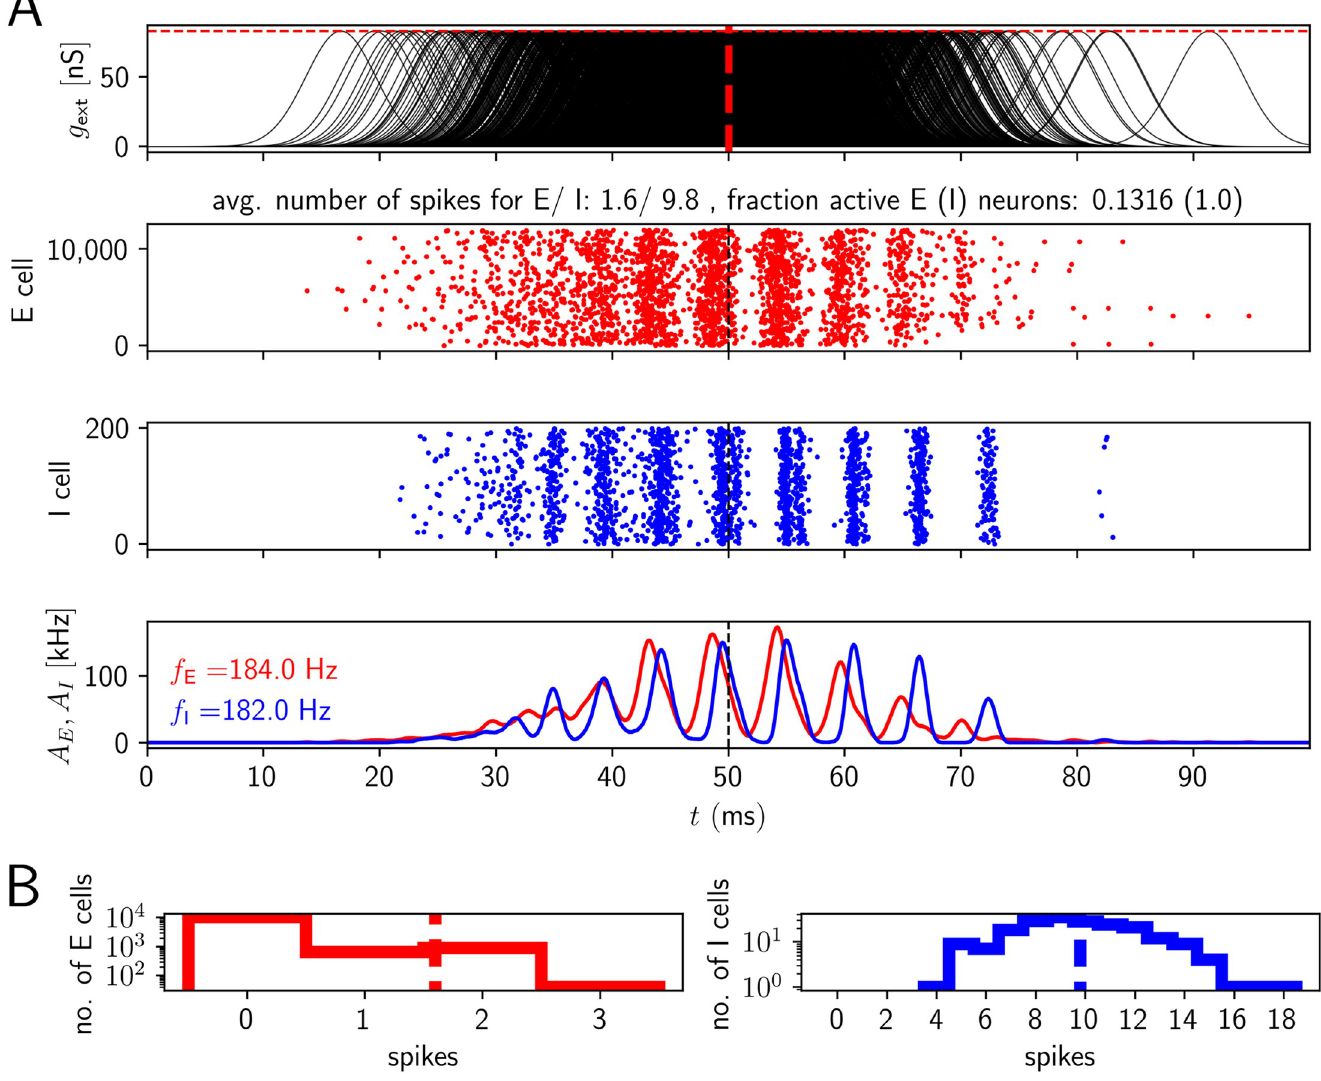
Fig 5. Network activity for temporally narrow excitation of E cells (model 2). Each E cell receives an input pulse whose duration is comparable to the interval between two ripple waves. The peak times of the pulses are distributed. E and I populations spike at ripple frequency, active E cells typically contribute one to two spikes to an event. A: Input pulses, spike rastergrams and network activities, displayed as in Fig 3. B: Histograms of spike counts during the displayed event. Parameter values as in Fig 6, ð � g ; n Þ ¼ ð 83 nS ; 1580 Þ E